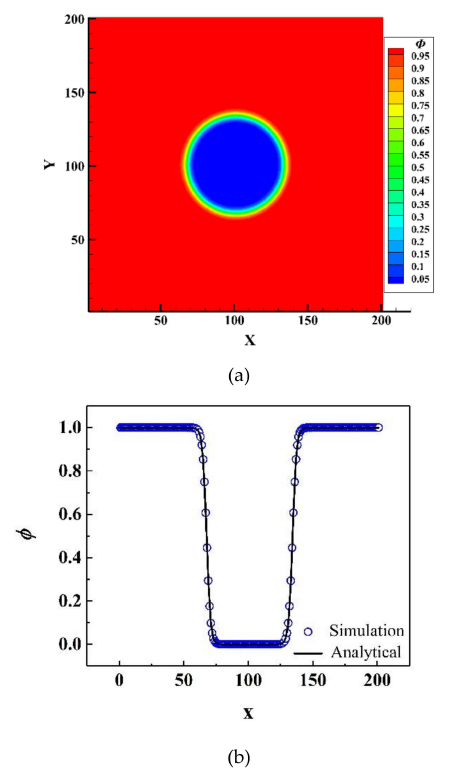
Figure2. Phasefielddistributioncontour( a )ofthestablebubbleandphasefielddistributioncomparison in the radial direction ( b ) through the bubble.